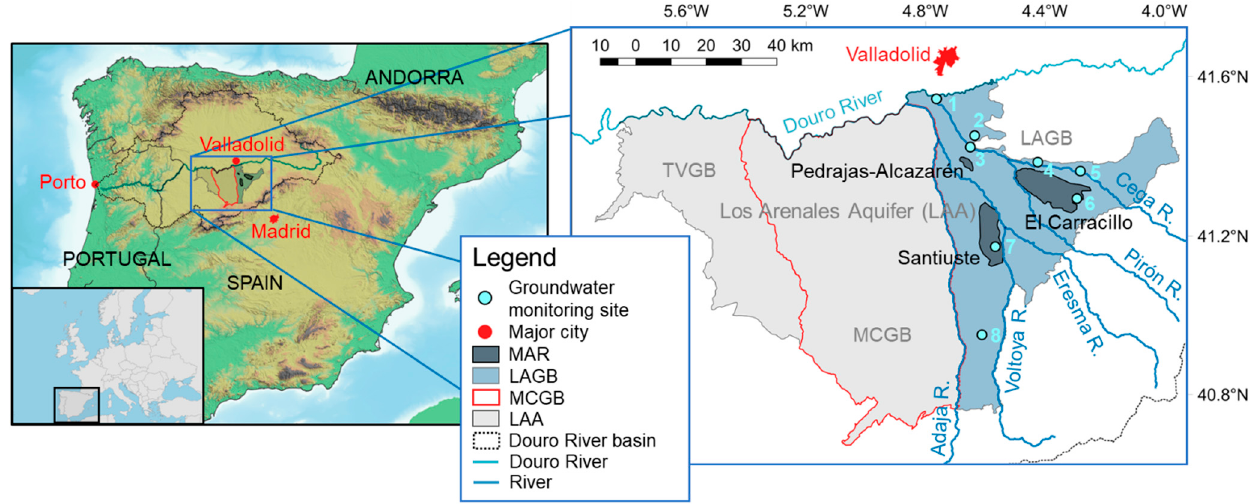
Figure 1. Location of Los Arenales Aquifer (LAA), Los Arenales (LAGB), Medina del Campo (MCGB), and Tierra del Vino (TVGB) groundwater bodies and Los Arenales MAR systems: El Carracillo, Pedrajas-Alcazarén, and Santiuste.